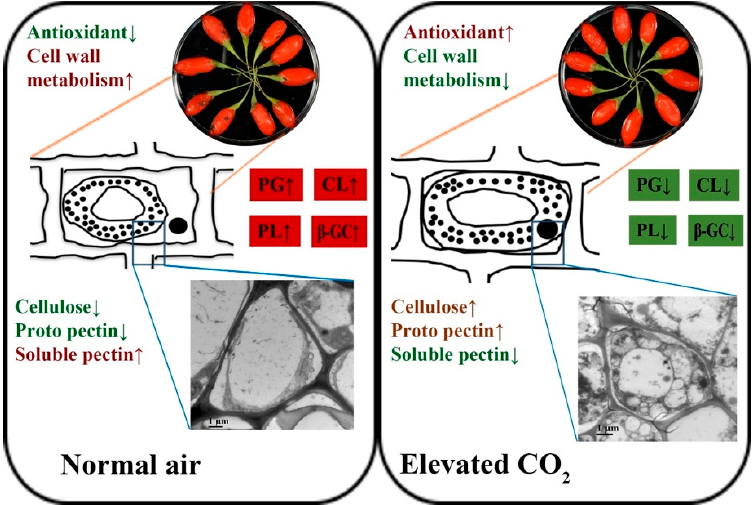
Figure 6. The potential model of elevated CO 2 on cell wall degradation in wolfberry fruit. The red and green boxes refer to promotion and inhibition effect, respectively.